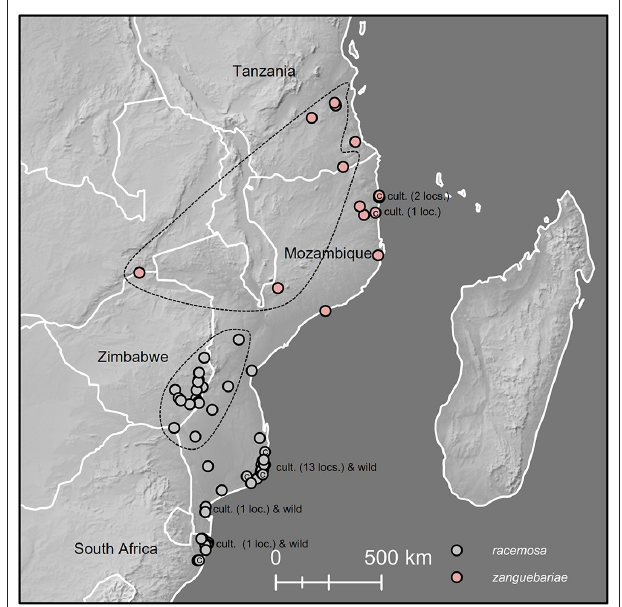
FIGURE 2 | Distribution map for C. racemosa and C. zanguebariae . Dotted lines indicate localities above 150m for C. racemosa and 200m for C. zanguebariae . Cult. (cultivated) indicates localities of farmed coffee; loc./locs. =